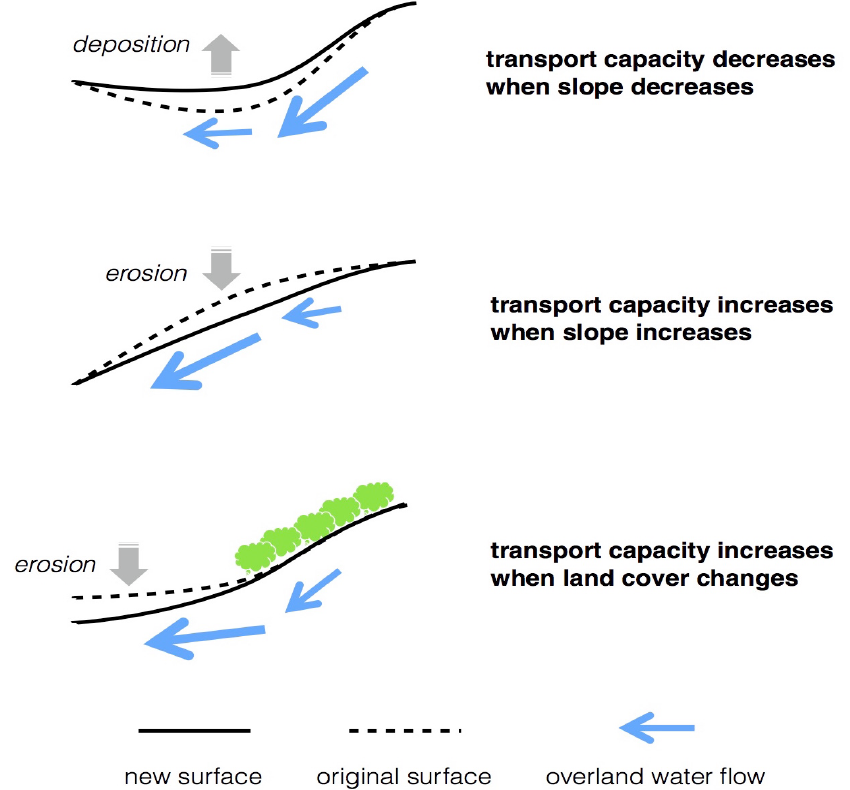
Figure 1. A schematic representation of the effect of topographic and vegetation change on the calculation of erosion and deposition in the MML surface process model. Our modeling approach assumes that the sediment load in flowing water is normally near transport capacity (a spatially and temporally dynamic equilibrium influenced by factors like the quantity of water, slope, and land-cover). In a three-dimensional landscape, changes in one of these factors will alter transport capacity. Sediment will then be entrained or deposited until a local equilibrium between sediment load and transport capacity is reached. Hence, increases in slope (or, convexity) will tend to result in erosion; decreases in slope (or, concavity) will tend to result in deposition. Reduction of vegetation (shown as green bushes) will tend to result in increased erosion or decreased deposition, depending on the localized change in slope. (Length of blue arrows schematically represents transport capacity of overland